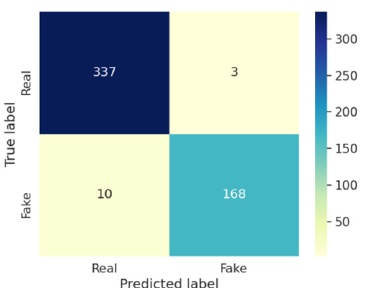
Figure 9. Confusion Matrix of our model with the Celeb-DF v2 dataset [52]. Top-right, top-left, bottom-right, bottom-left means false-positive, true-negative, true-positive, false-negative in order.